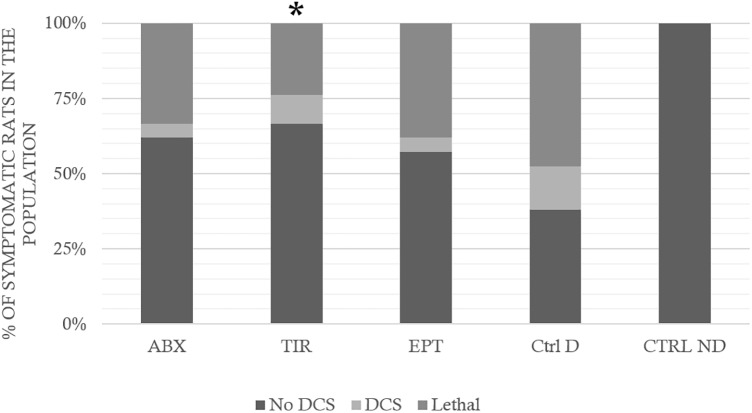
Clinical status after the hyperbaric protocol exposure. ABX: Abciximab; TIR: Tirofiban; EPT: Eptifibatide; Ctrl D: Control Dive; Ctrl ND: Control No Dive. The Lethal DCS status encompasses rats that die in the hour following the end of the hyperbaric protocol. The DCS status was attributed when the rat presented serious neurological signs in the form of paresis or paralysis of at least one limb, convulsions and/or reduced performance in SFI, AMPA locomotor tests, with a beam walk test score reduced by at least 2 points. The other rats are considered to be No DCS. ∗ notes significant difference (p < 0.05) in the occurrence of symptoms compared to the Ctrl D group.